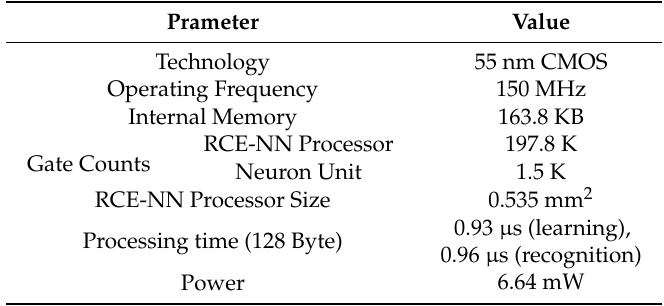
Table 2. Key features of the implemented restricted coulomb energy neural network (RCE-NN) processor.